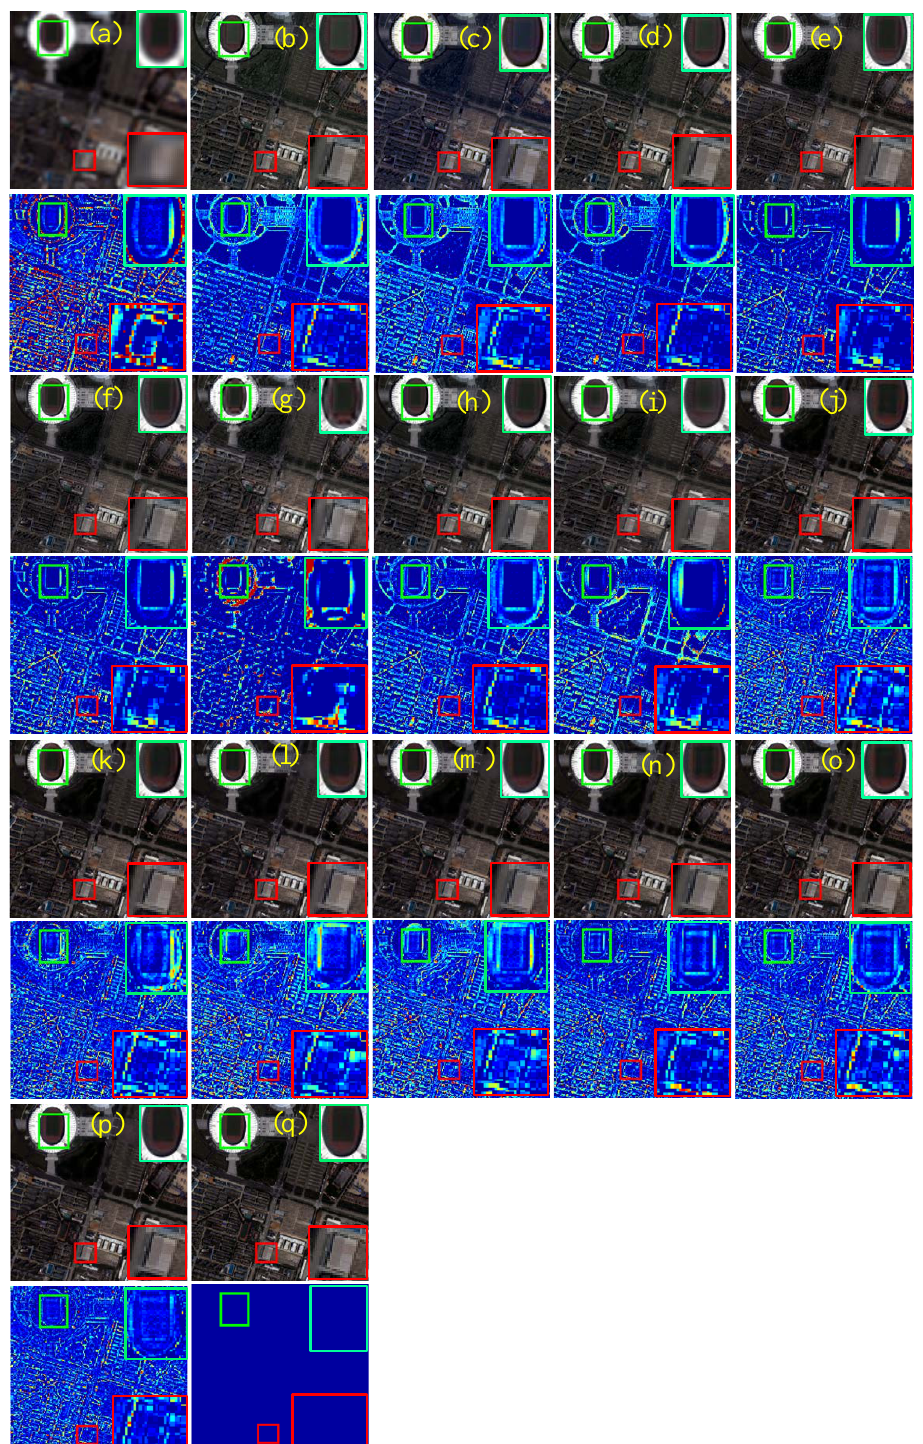
Figure 4. Visualization of image sharpening results in reduced resolution and their corresponding absolute error image. The input LRMS and PAN images from the IKONOS dataset with sizes of 64 × 64 and 256 × 256, respectively. ( a ) EXP; ( b ) PCA; ( c ) IHS; ( d ) GS; ( e ) HPF; ( f ) SFIM; ( g ) Indusion; ( h ) FE-HPM; ( i ) PWMBF; ( j ) PNN; ( k ) DRPNN; ( l ) PercepPan; ( m ) PGMAN; ( n ) BAM; ( o ) MC-JAFN; ( p ) Our; ( q )